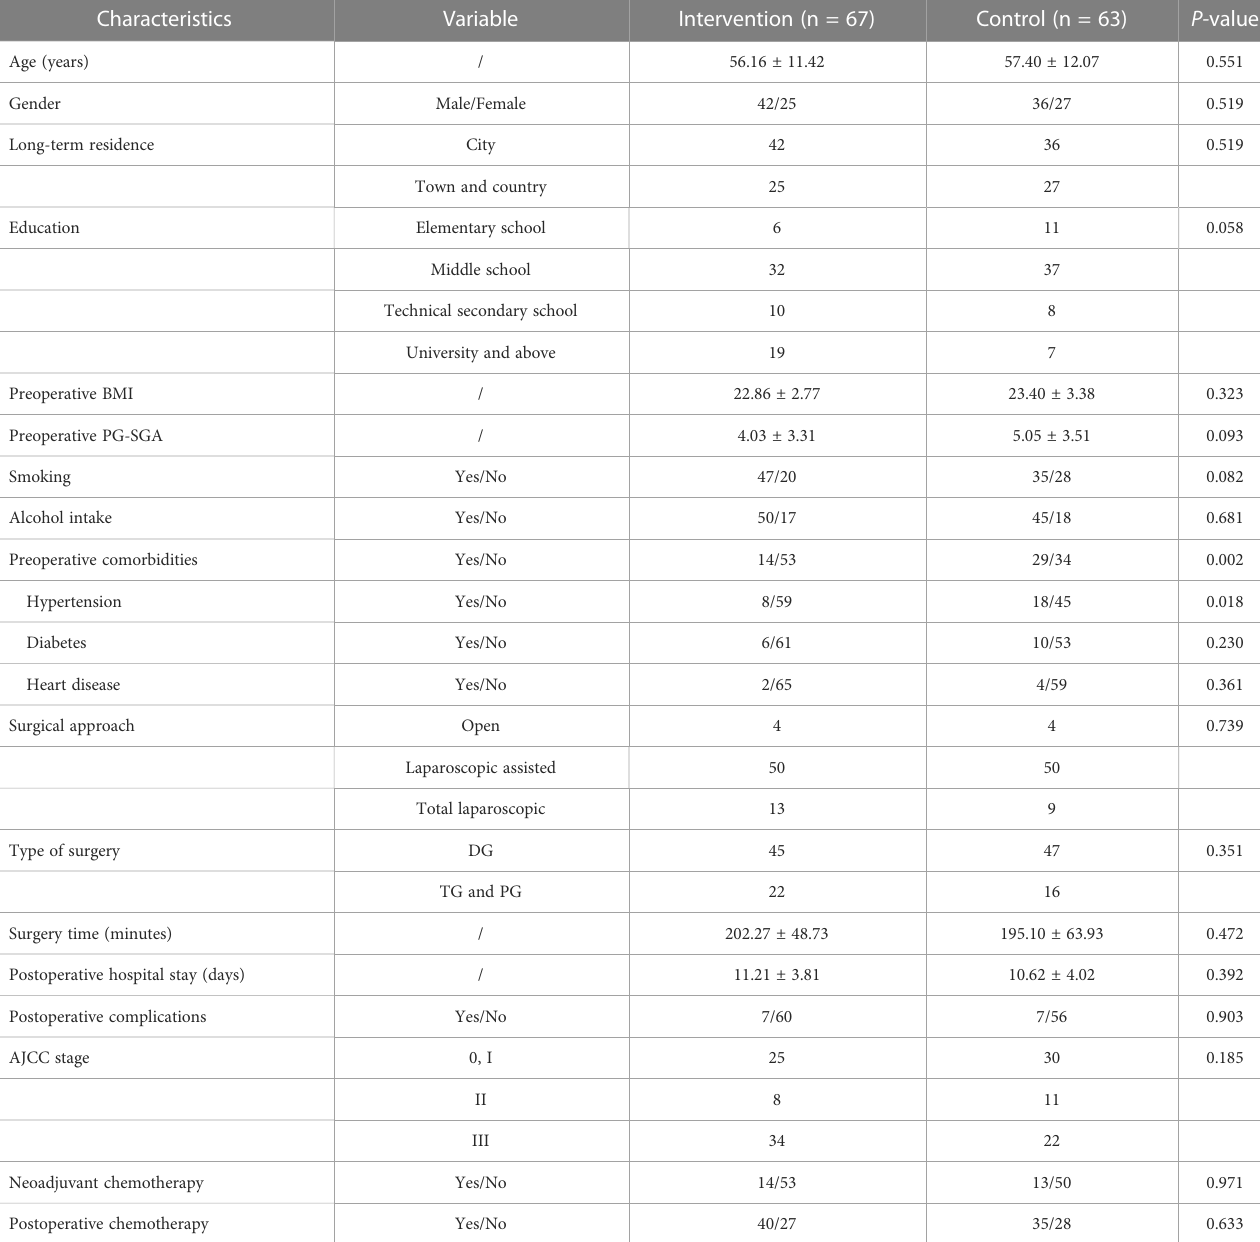
TABLE 1 General characteristics of gastrectomy patients at baseline.